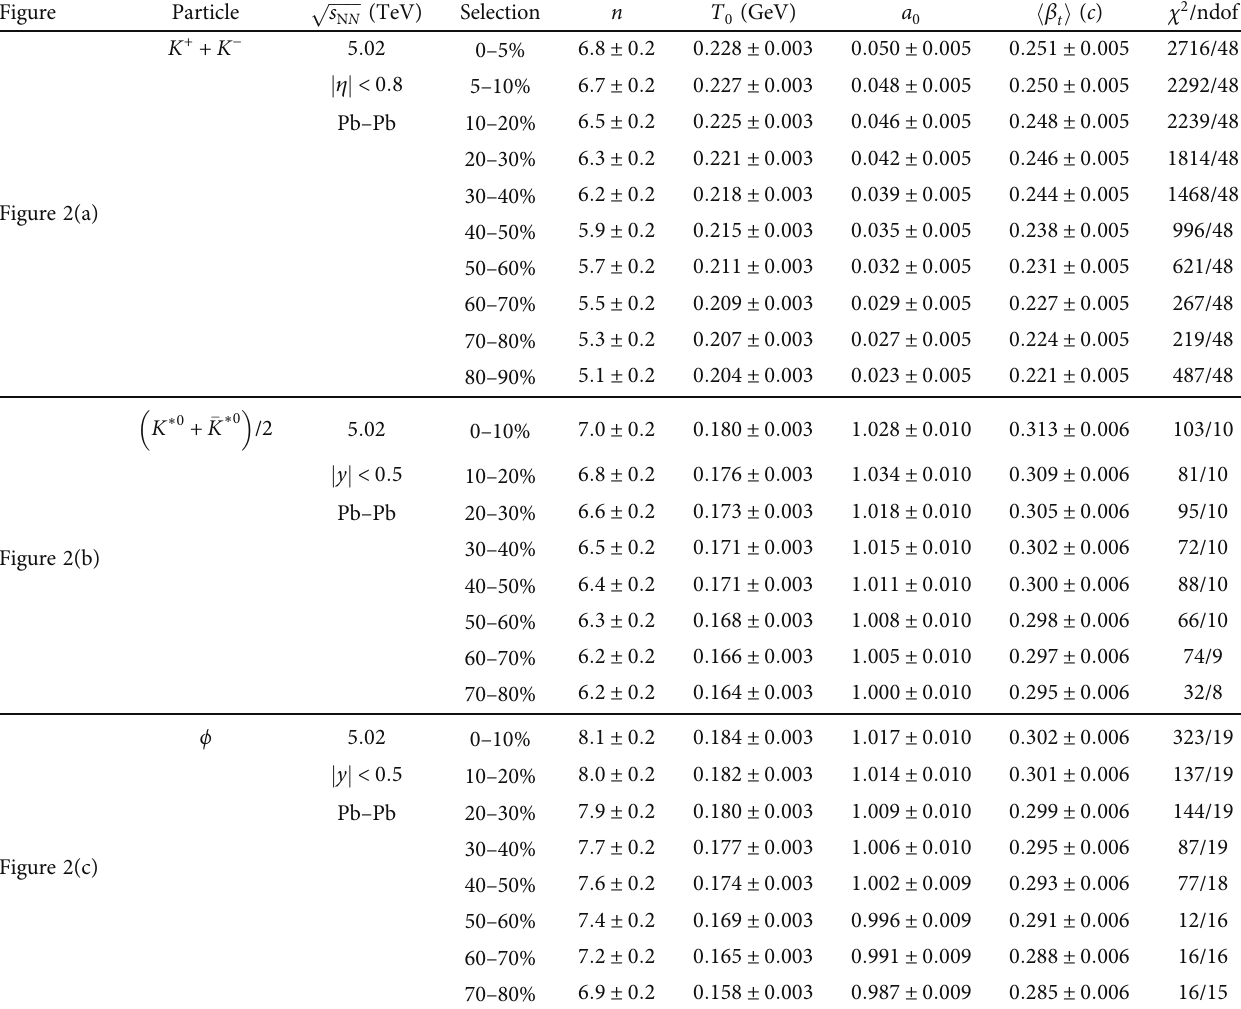
a h β i , χ 2 , and ndof corresponding to the solid curves in Figure 2. 0 , 0 , t ffiffiffiffiffiffiffi s N N